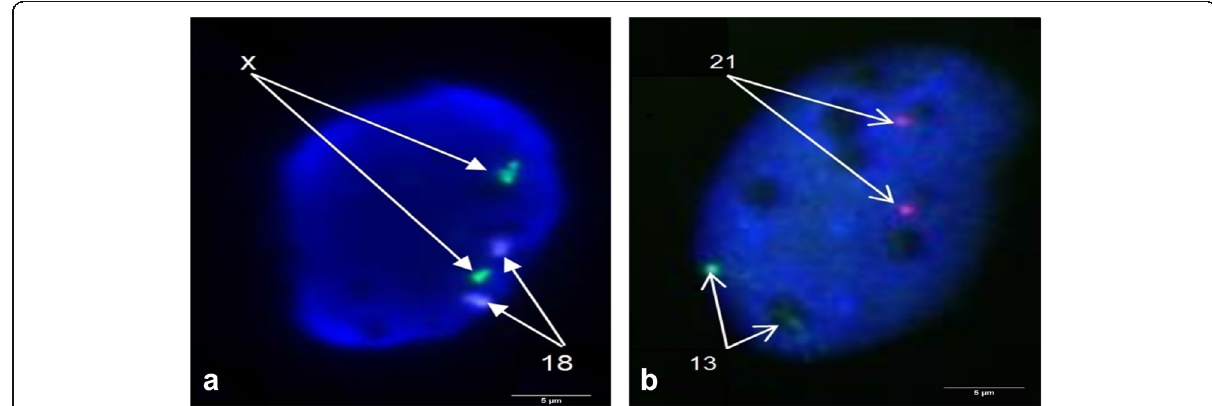
Fig. 3 Nucleus hybridization of probes with target chromosomes of one blastomere biopsied from cleavage-stage embryo for PGT-A applying FISH technique. The image showed a female normal nucleus for chromosome X (green), chromosome Y (red), and chromosome 18 (blue) in first round as well as chromosome 13 (green) and chromosome 21 (red) in the second round using specific probes (Cytocell, OGT Company, Cambridge, UK) in each